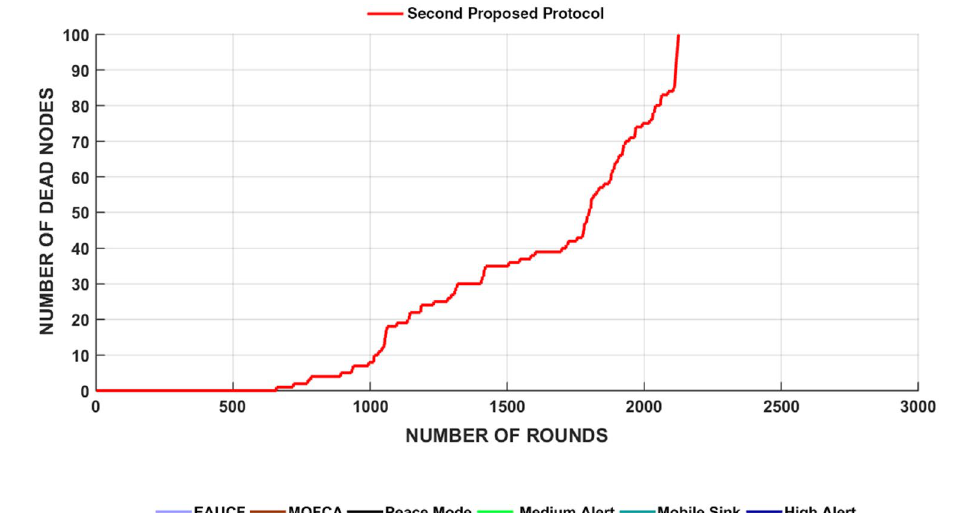
Fig. 18 Number of dead nodes in relation to the number of rounds in scenario 4 in the second proposed protocol